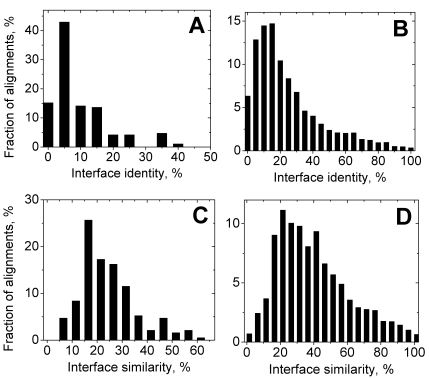
Distributions of interface identities and similarities in alignments containing all interface residues.Panels A and C show the distributions for the alignments with maximum query sequence coverage 40% and panels B and D show the distributions for the alignments irrespectively of query sequence coverage. For the definitions of interface identity and similarity see text.